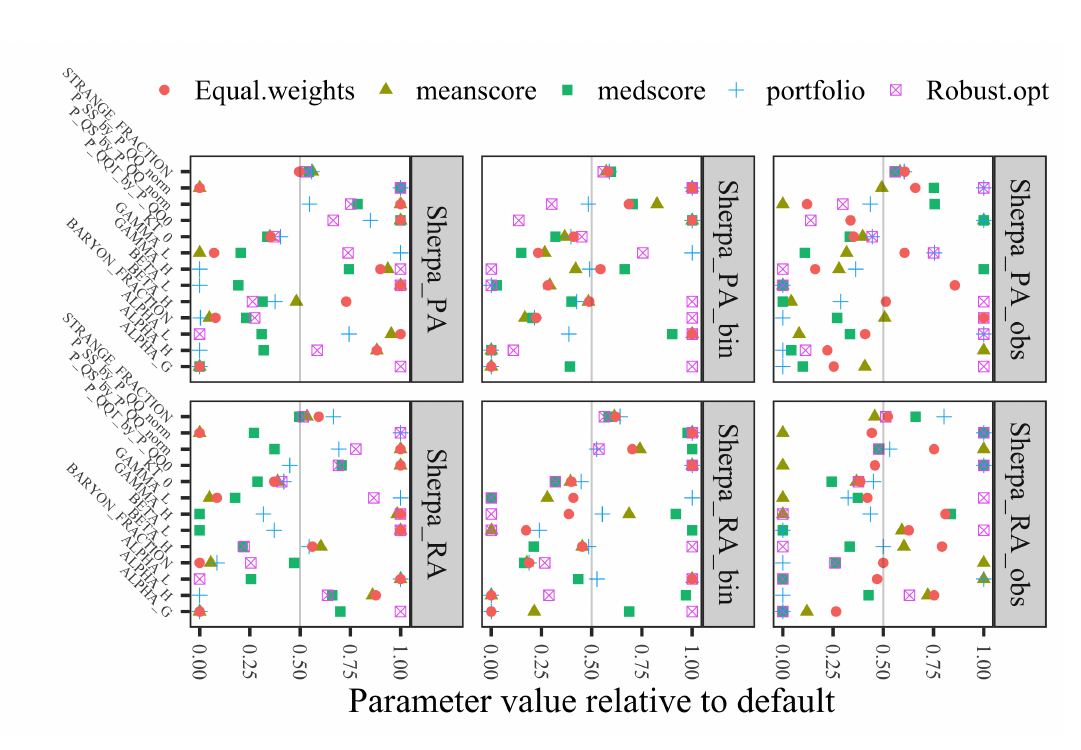
Figure 18: Comparison of the optimal parameter values for S HERPA obtained with the different optimization methods when no, observable, and bin data filtering was applied and the rational and polynomial approximation was used. Values are nor- malized to [ 0,1 ] . Table 28: Optimal parameter values for the S HERPA dataset obtained with all methods using the cubic polynomial approximation after using outlier detection to remove observables from the optimization (3 observables